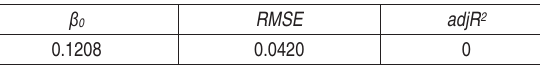
Table 1. Estimated parameters for model 0, RMSE